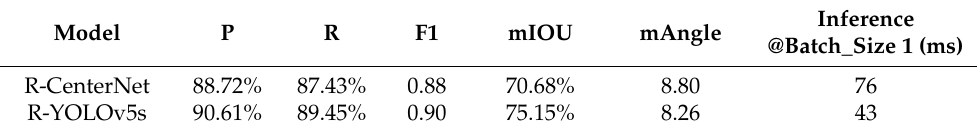
Inference @Batch_Size 1 (ms)